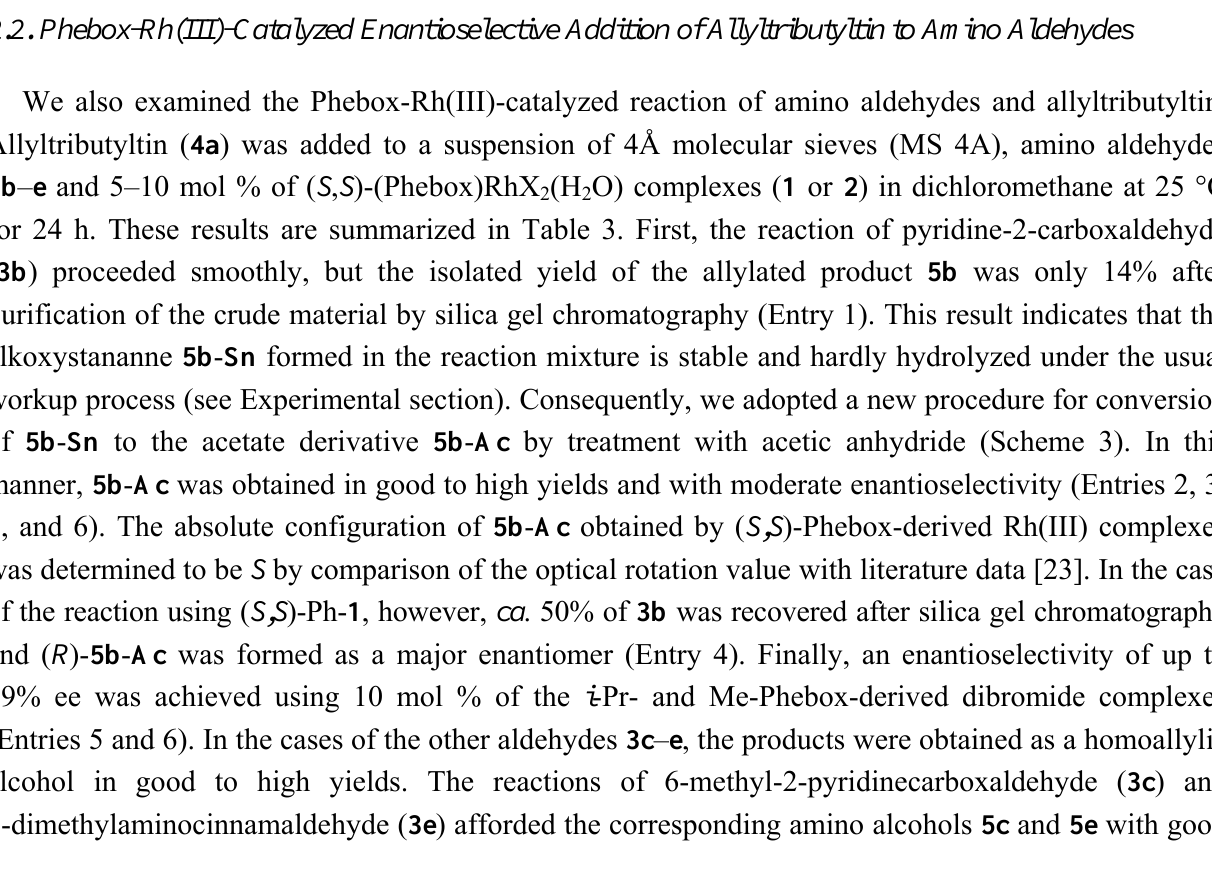
Table 2. Selected bond distances (Å) and angles (deg) for ( i -Pr-Phebox)RhCl